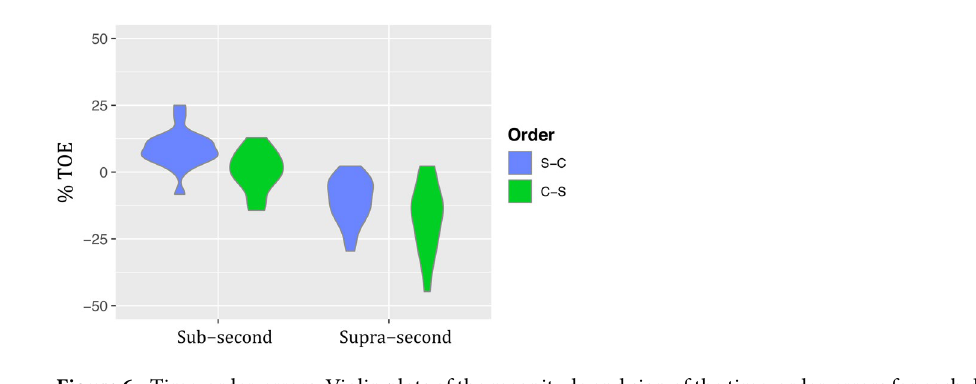
Figure 6. Time-order-errors. Violin plots of the magnitude and sign of the time-order-errors for each duration range and presentation order, as percentage of standard duration, across participants of Experiment 2 (linearly spaced ratios). The corresponding ANOVA showed a main effect of duration range ( p < 0.001, η 2 G = 0.48), a main effect of presentation order ( p < 0.001, η 2 G = 0.14) and a non-significant interaction ( p = 0.45, η 2 = G